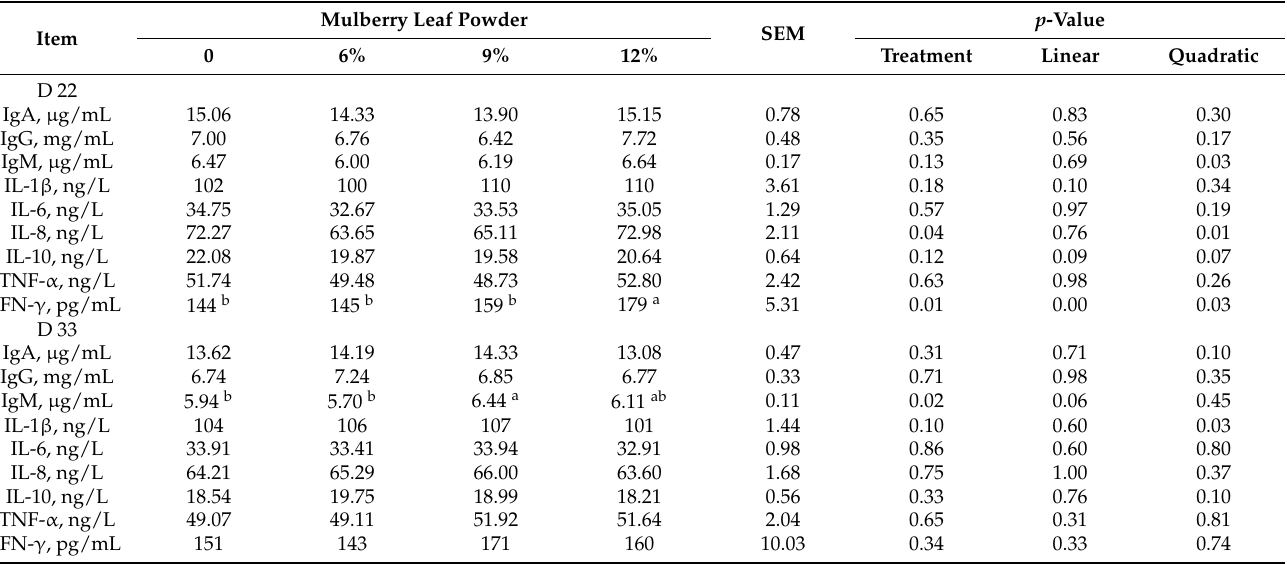
Table 2. Effect of mulberry leaf powder of varying levels on serum immunity and inflammatory factors in finishing